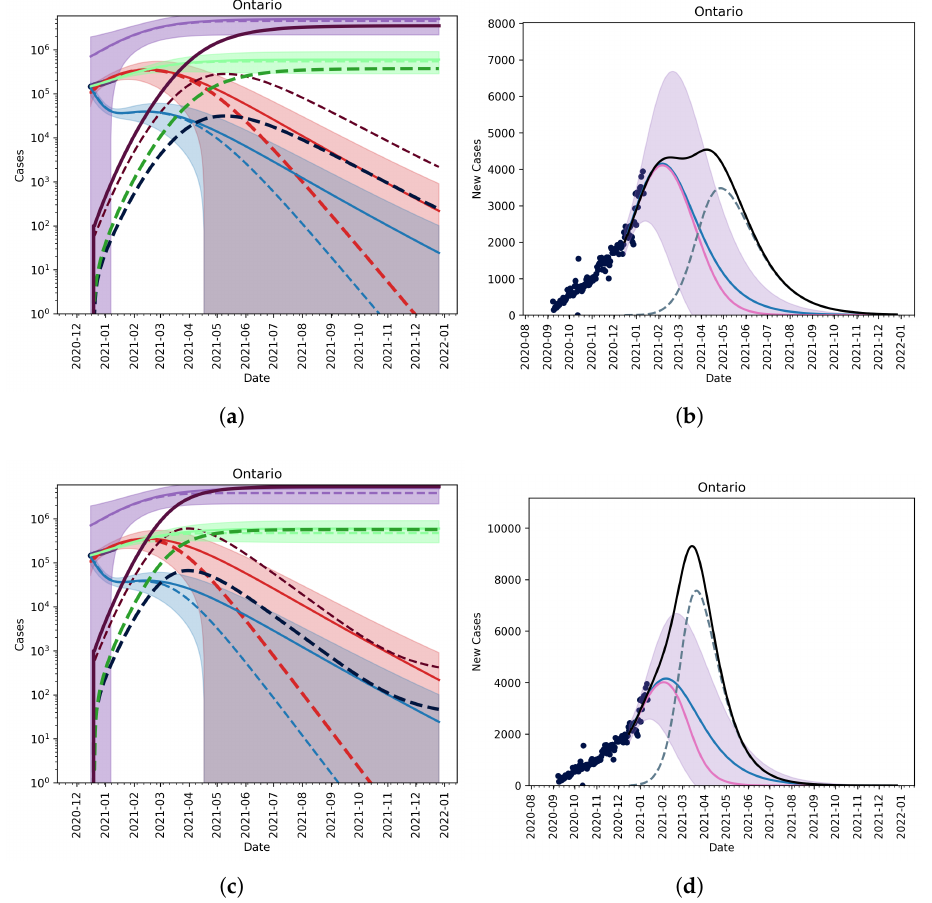
Figure 1. Model fit given different initial conditions for the mutant strain. ( Top row , ( a , b )) 100 cu- mulative cases on 26 December 2020. ( Bottom row , ( c , d )) 1000 cumulative cases on 26 December 2020. ( Left column , ( a , c )) The active and cumulative cases are shown given the model with (dashed lines) and without (solid lines) the mutant strain (dashed lines). Active mild and severe wildtype infected cases are shown in red and blue. Active and severe mutant infected populations are shown in dark red and dark blue. The cumulative known and total cases of the wildtype and mutant strains are shown in light and dark green, and light and dark purple, respectively. ( Right column , ( b , d )) The new reported cases per day given the model with (wildtype—solid pink line, mutant—dashed blue line, and total—solid black line) and without (wildtype—solid blue line) the mutant. Ontario reported case data, from September 2020 to January 2021, are also shown (dots).